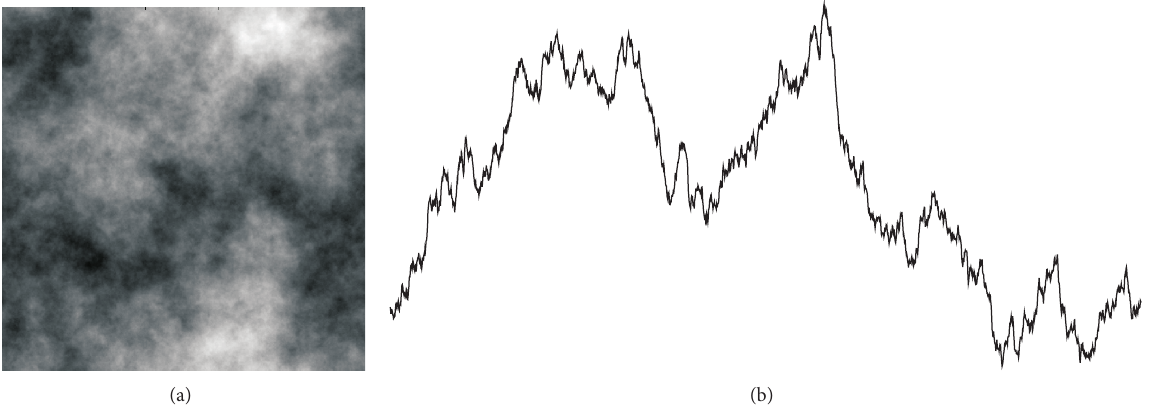
Figure 1: Graphical representations of a fractal rough surface with 𝐻 = 0.6 : (a) grayscale representation and (b) a cut through the surface.